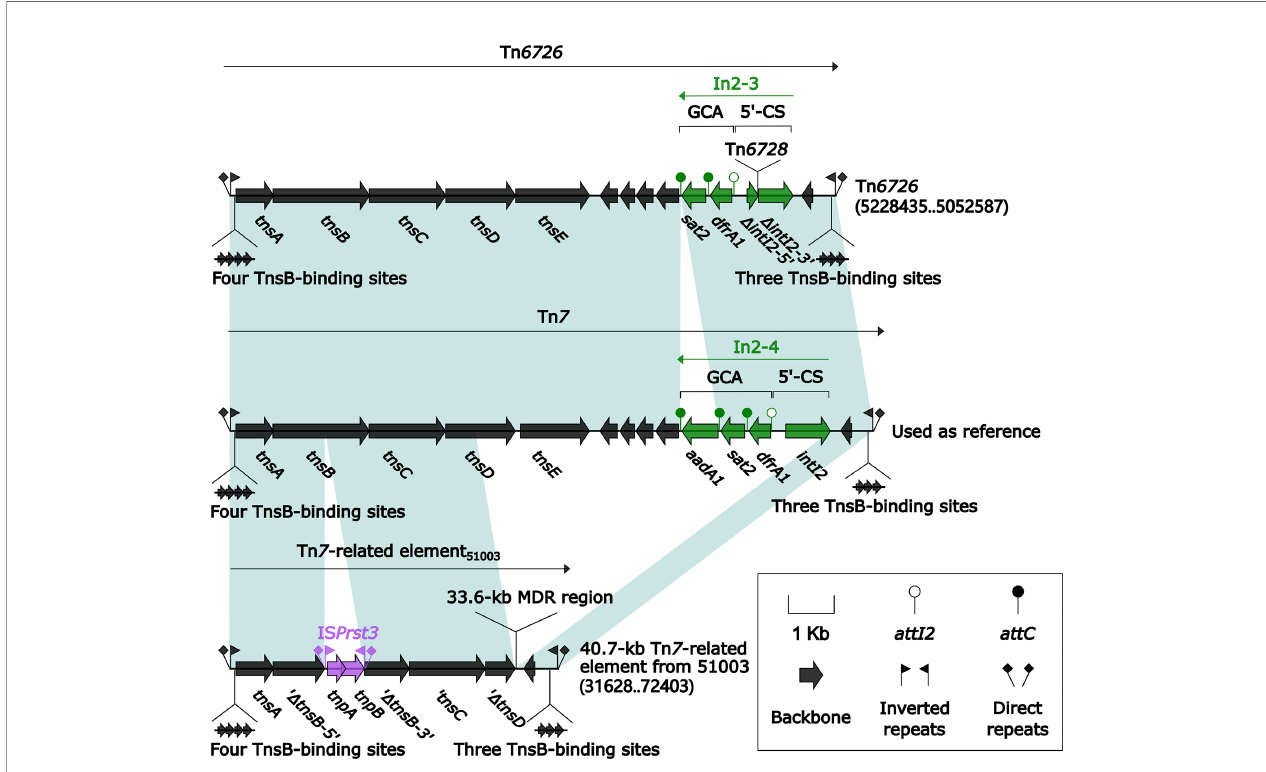
FIGURE 8 | Comparison of Tn 7 and its two derivatives Tn 6726 and 40.7-kb Tn 7 -related element. Genes are denoted by arrows. Genes, mobile elements, and other features are colored based on their functional classi fi cation. Shading denotes regions of homology (nucleotide identity ≥ 95%). Numbers in brackets indicate nucleotide positions within the chromosomes of strains KP64 and 51003. The accession number of Tn 7 used as reference is